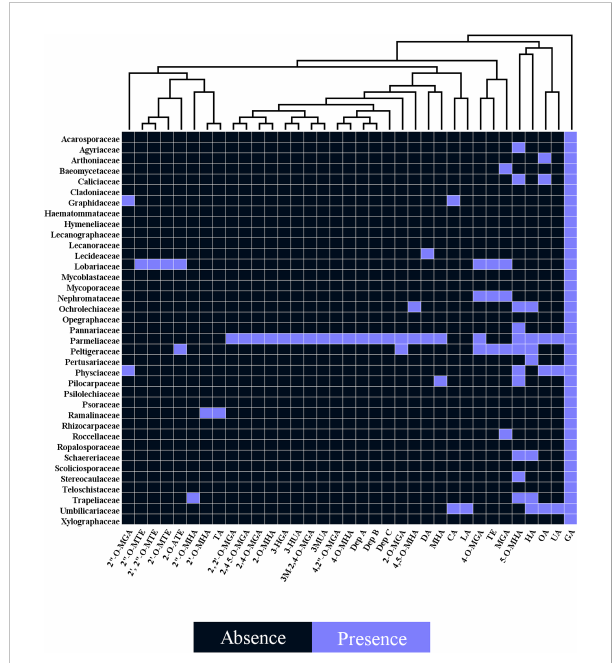
FIGURE 4 Heatplot of tridepside-producing lichen families. The plot shows the presence of different tridepsides in various lichen families (tridepsides ’ abbreviations correspond to those of Figure 3